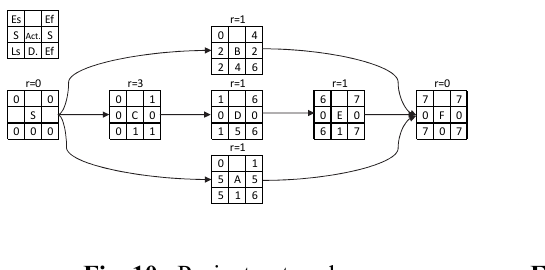
Fig. 10. Project network Fig. 11. Project schedule before resource